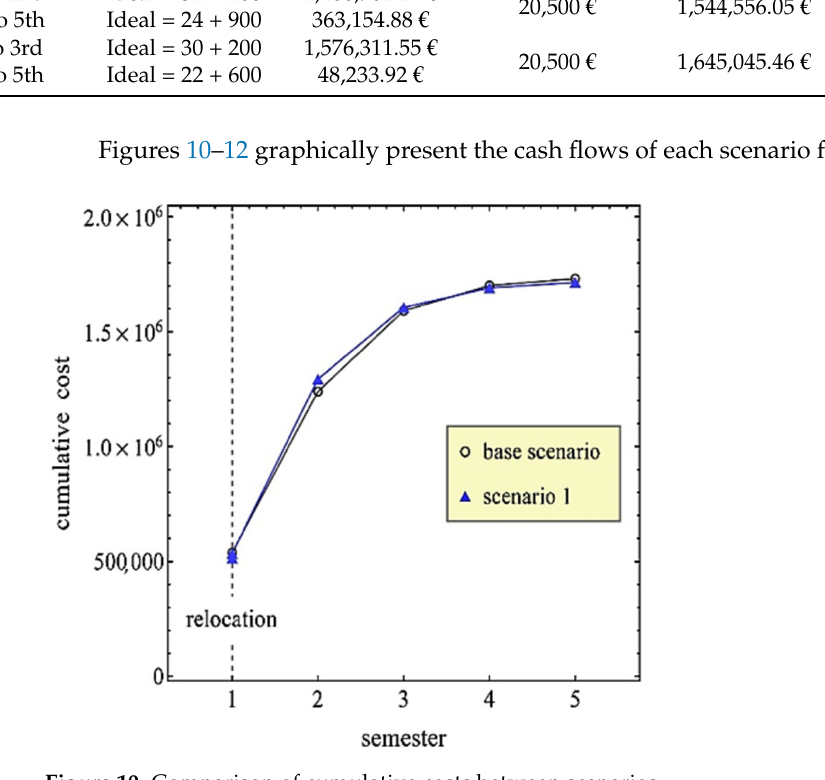
Figure 12. Comparison of cumulative costs between scenarios. Sensitivity analysis 1: The construction methodology splits the project into two parts, the first part from chainage 17 + 700 to chainage 33 + 100 and the second part from chainage 33 + 200 to chainage 48 + 500. Thus, a site relocation is needed after the comple- tion of the first part. The resulting cost is compared with the total cost for the “ideal” location (i = 29 + 100) of construction site without relocation (TC = 1,730,958.54€); a profit of 57,061.17€ (Table 11) is accrued. That profit accounts almost for 3.3% of the total cost of the construction site and for 0.11% of the total cost of the project (TC = 54,000,000€). Table 11. Profit gained by splitting the project into two parts. Chainage